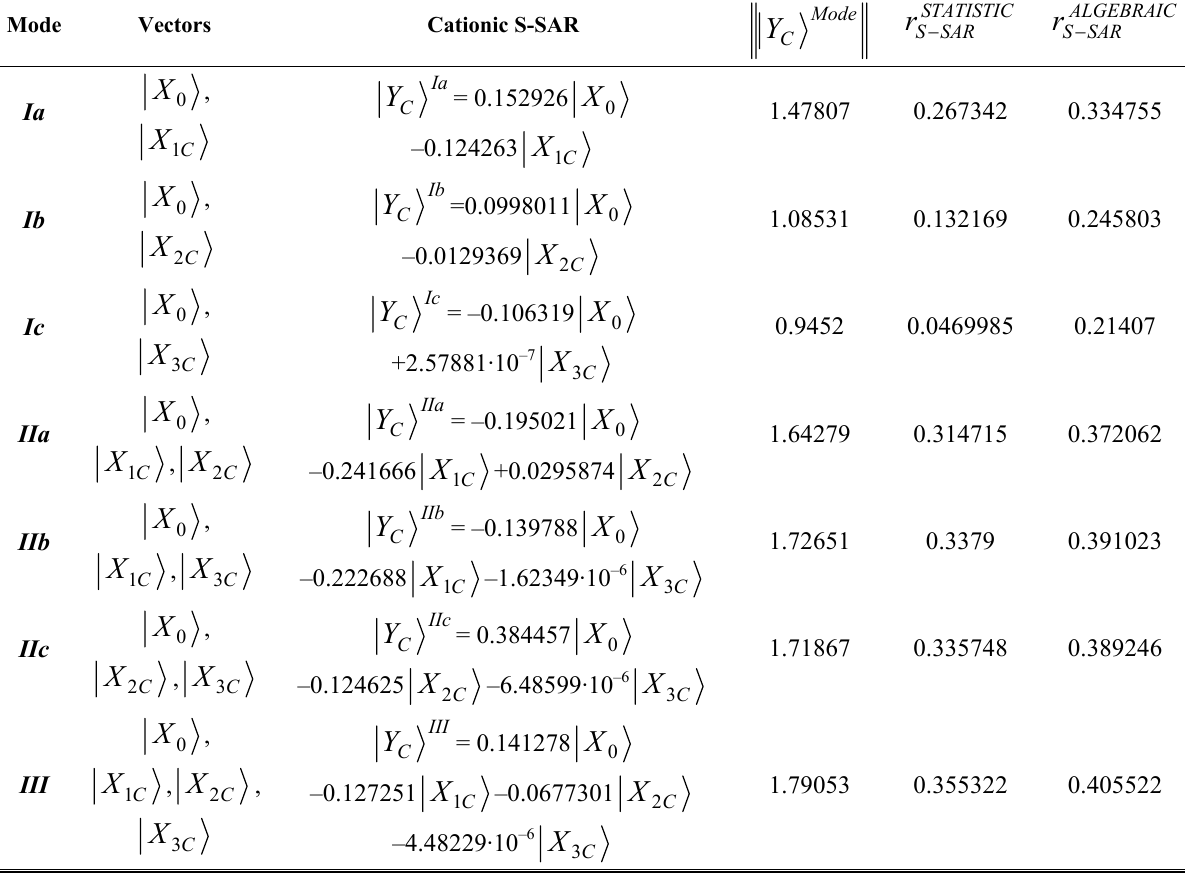
Table 3: Spectral structure activity relationships (S-SAR) of the ionic liquids of Figure 2 against Vibrio fischeri toxicity, and the associated computed spectral norms with ║ | Y and algebraic correlation factors, computed upon the relations (6), (7), and (8), throughout the possible correlation models considered from the cationic data in Table 2, respectively. Mode Vectors Cationic S-SAR Mode